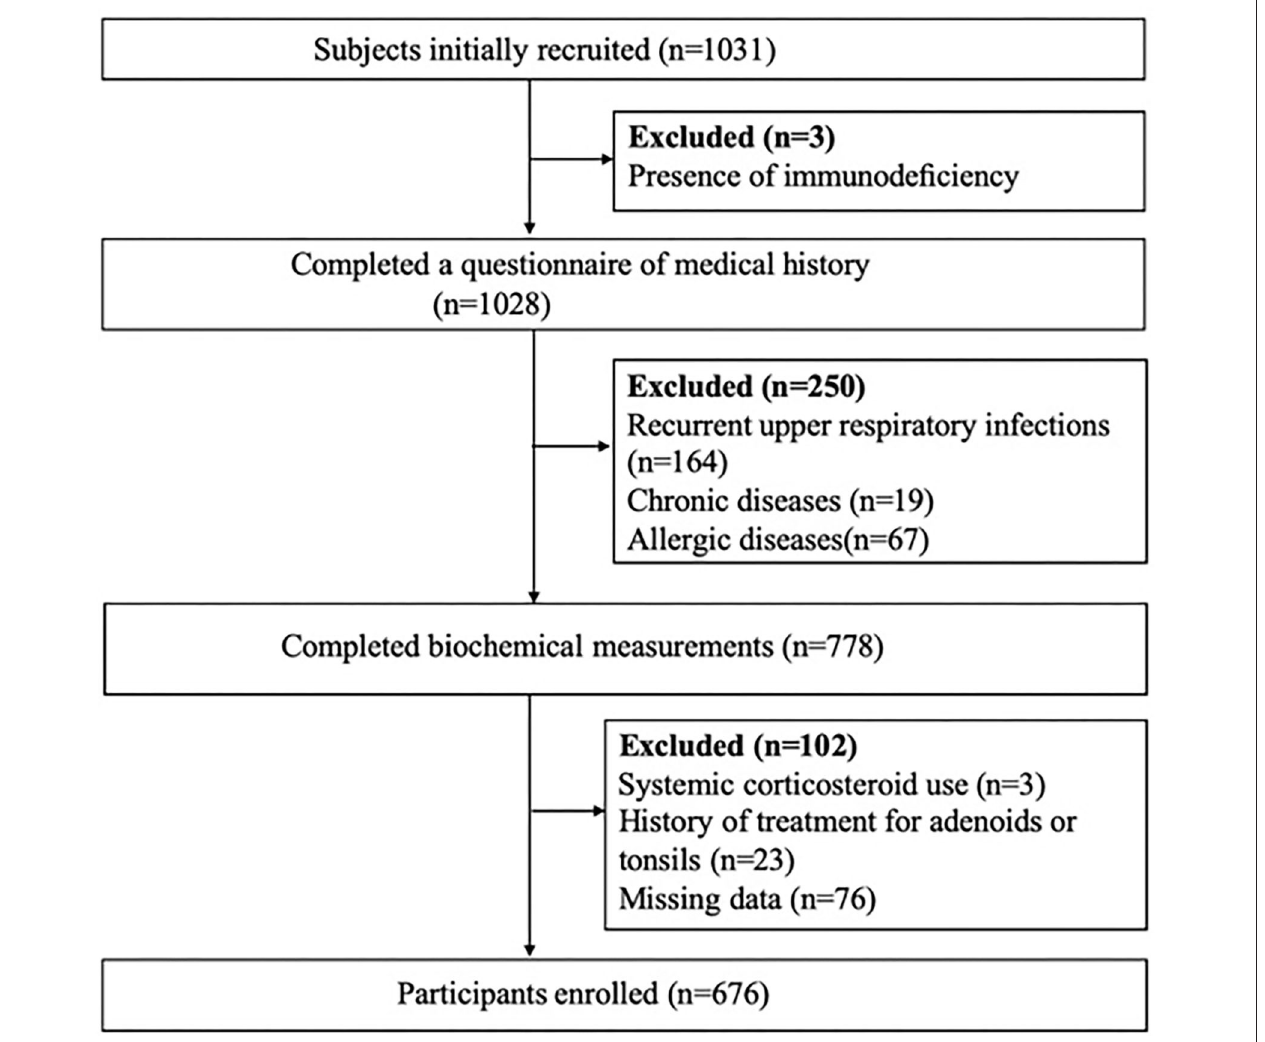
FIGURE 1 | Flow chart of study population